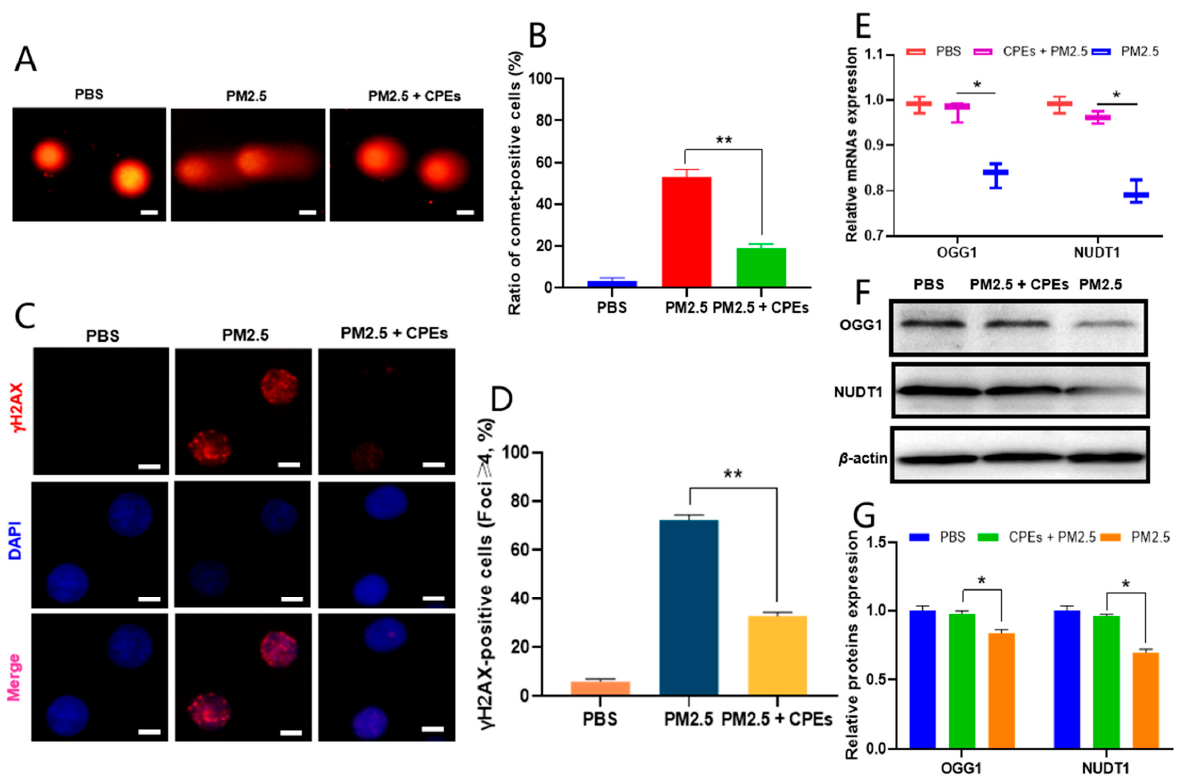
Figure 6. Protective effect of CPEs against genotoxicity induced by PM2.5. Cells were co-treated with CPEs (10 mg mL − 1 ) and PM2.5 (100 µ g mL − 1 ) for 24 h. ( A ) Alkaline comet assay detected DNA single-strand damage and representative photographs of comets (scale bar: 10 µ m). ( B ) Analysis results represented the ratio of comet cells from 200 randomly chosen cells. ( C ) DNA double-strand breaks were illustrated by γ H2AX foci formation. Anti- γ H2AX monoclonal antibody (red) was used for DNA damage foci immunofluorescence and DAPI (blue) was used for nuclei staining (scale bar: 10 µ m). ( D ) Percentage of γ H2AX-positive cells of fibroblasts. ( E ) The relative mRNA expression of NUDT1 and OGG1 were normalized to β -actin expression. ( F , G ) Western blot analysis of NUDT1 and OGG1 protein levels with PM2.5 or plus CPE treatment at 24 h and the relative protein expression analysis results. All results are expressed as mean ± SD of three biological replicates. * p < 0.05; ** p < 0.01 compared with PM2.5.